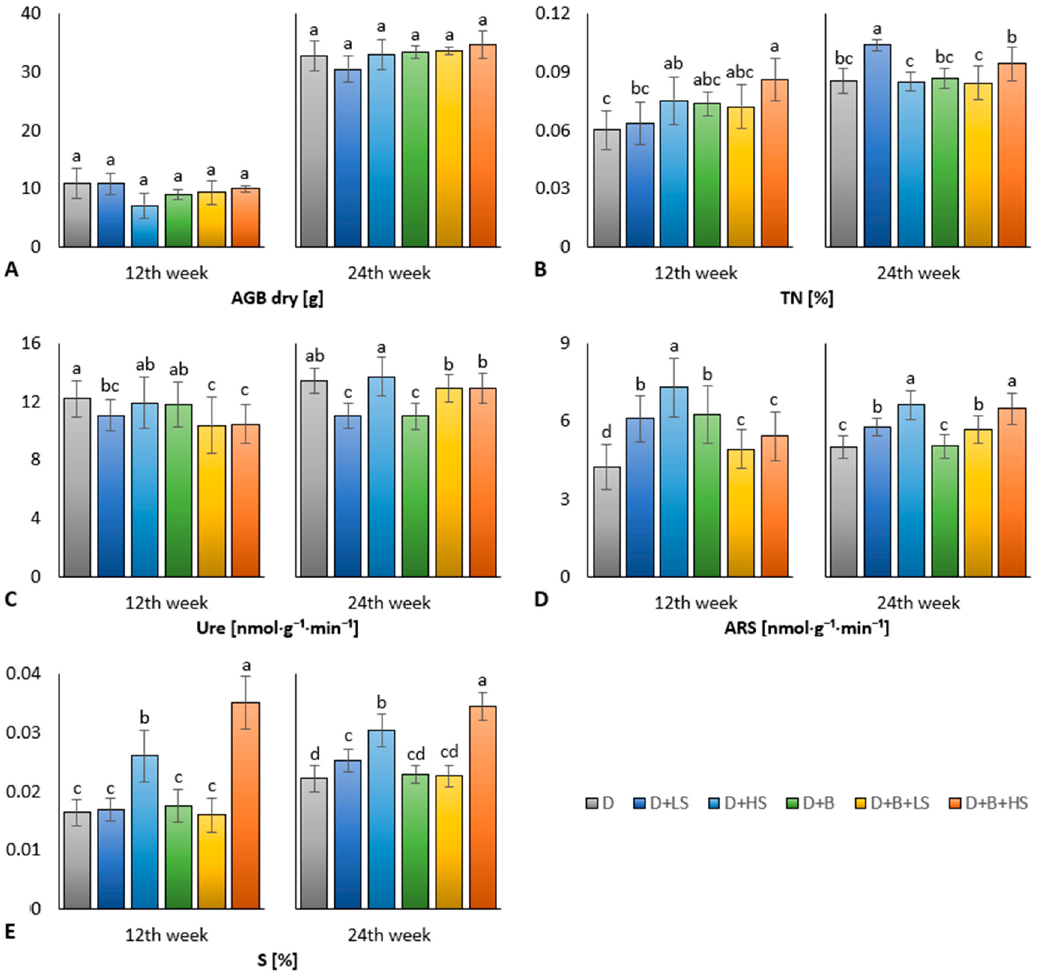
Figure 1. Dry aboveground biomass ( A ), soil total nitrogen ( B ), urease ( C ), and arylsulfatase activity ( D ), total sulphur ( E ) of experimental variants in the pre-cultivation (12th week) and the main cultivation (24th week) of maize in the pot experiment. Average values are displayed, error bars are standard deviation. The different letters of variant values indicate a statistical difference between them at the level p ≤ 0.05.